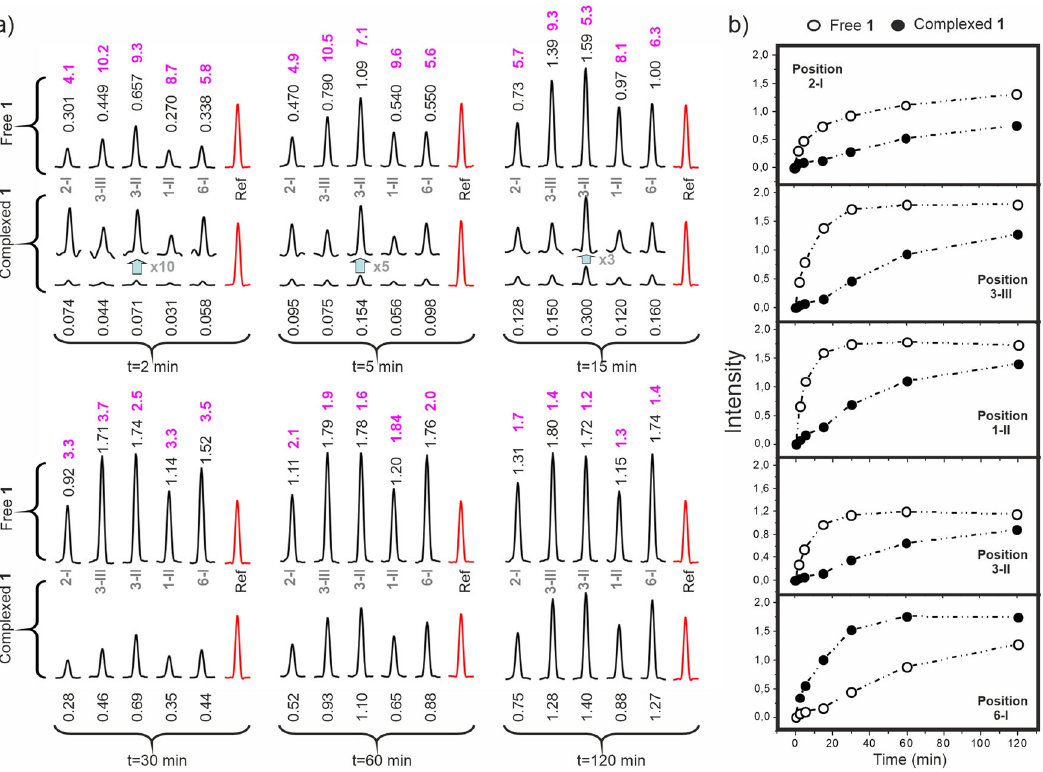
Fig. 3 Reactivity of kanamycin complexed to the A-Site. a Cross sections for the fi ve HSQC cross-peaks at different labelling times ( t = x), both in the absence (above) and presence (below) of the RNA receptor (for short reaction times, these latter peaks have also been scaled up for clarity). The corresponding intensity ratios are shown in magenta. b Intensity build-up curves for the fi ve HSQC cross-peaks measured in the absence and presence of RNA.